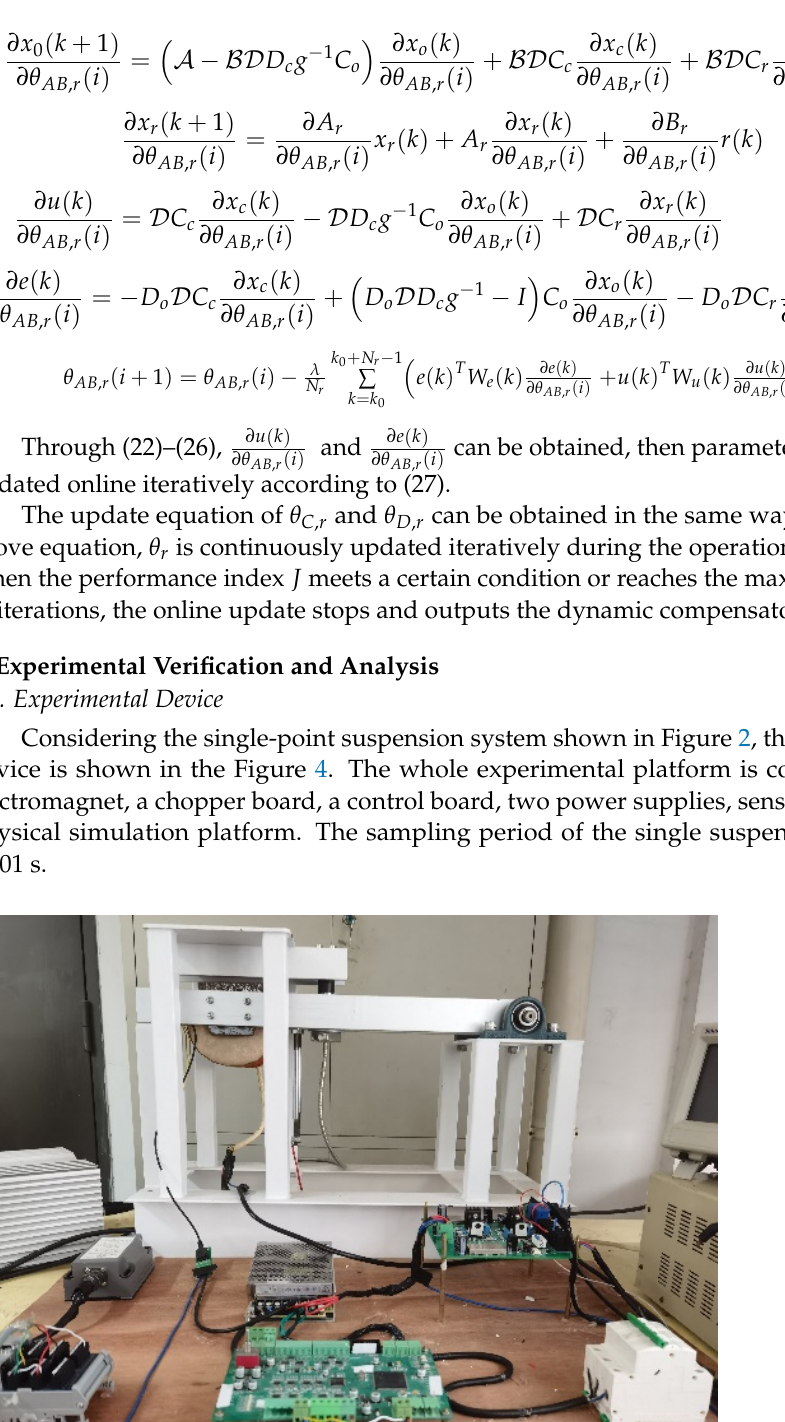
Figure 5. Gap during normal operation. 6.2. Observer and Performance Optimization Collecting input and output data during normal operation of the system and con- structing an observer-based residual generator according to [32].